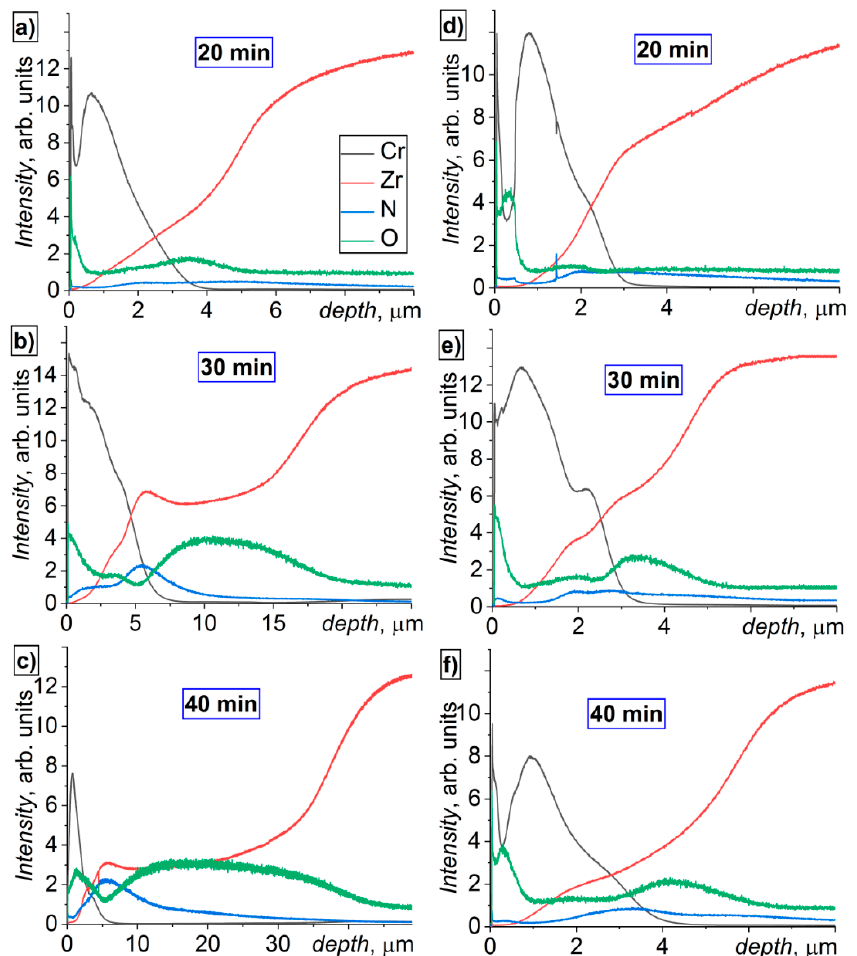
Figure 6. Depth distribution of elements in the Cr ( a – c ) and CrN/Cr-250 ( d – f ) samples after 20, 30, and 40 min oxidation in air.